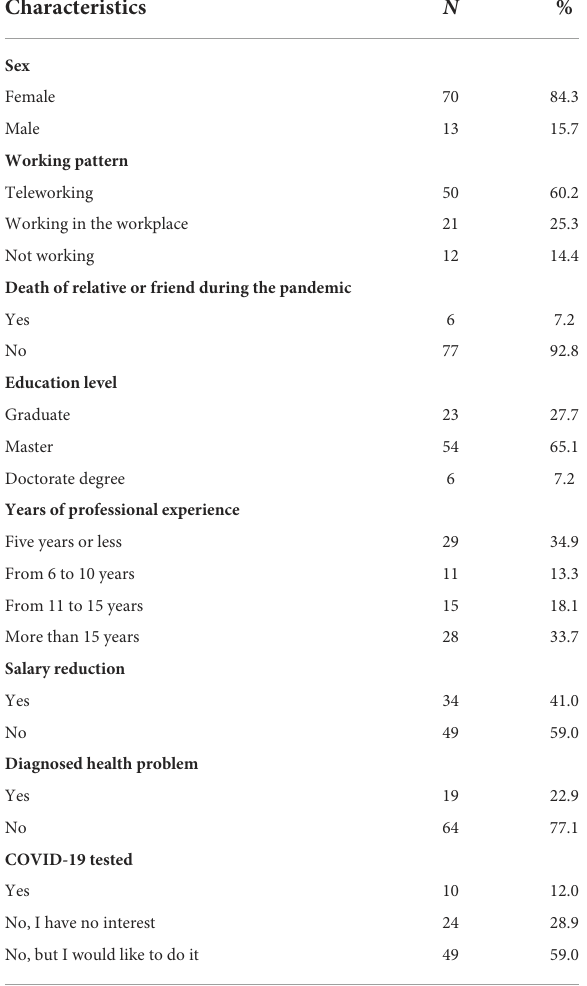
TABLE 1 Demographic and professional characteristics of psychologists ( n = 83).